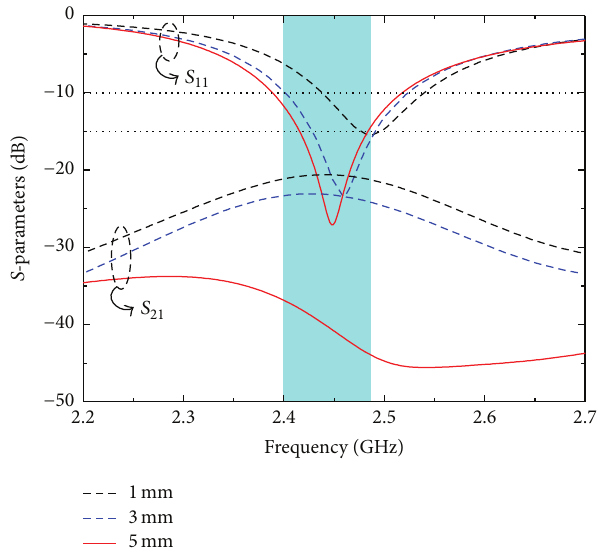
Figure 9: Simulated 𝑆 -parameters of full DGS MIMO antenna for different values of 𝐿 .